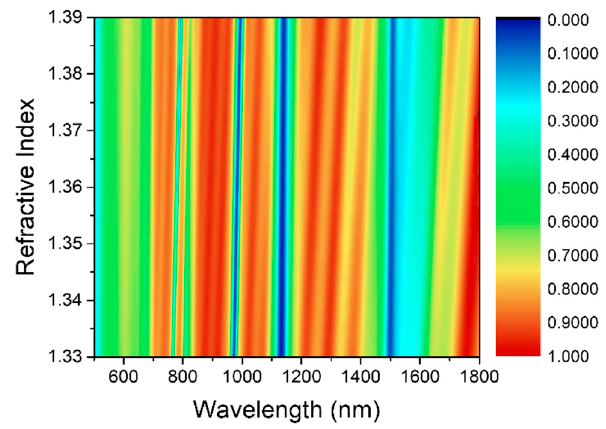
Figure 4. The reflectance spectrum of this structure in the range of analyte refractive index changes from 1.33 to 1.39, where the color represents the numerical value of the